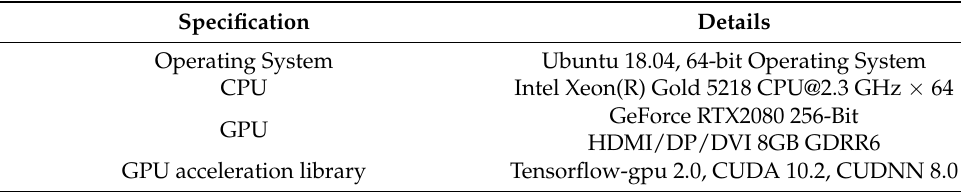
Table 2. Experimental platform